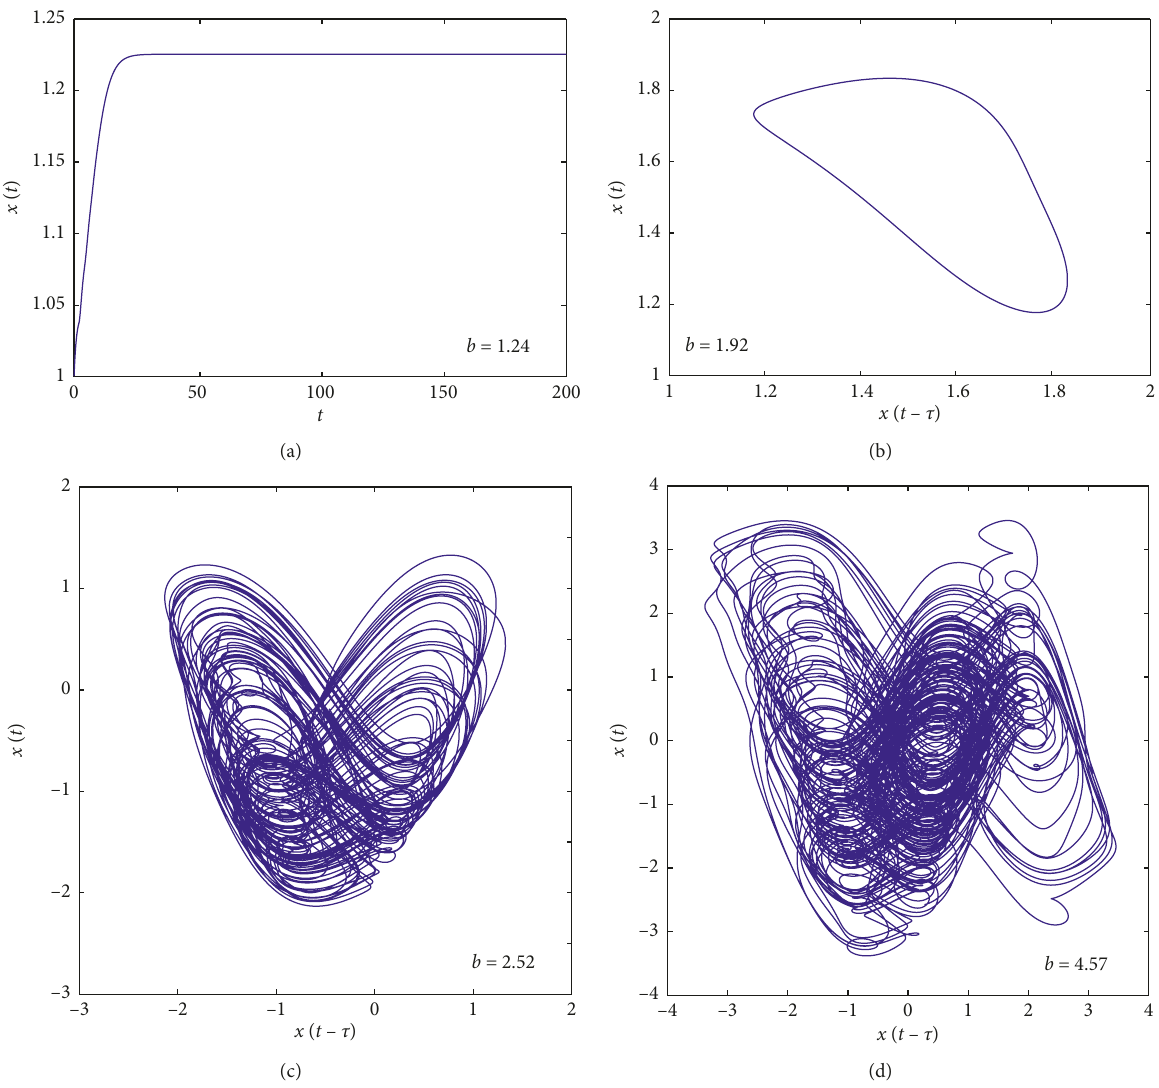
Figure 5: The initial condition is ϕ ( t ) � 1 for t ∈ [− τ , 0 ] throughout the investigation. Parameter a � 1, and time delay τ � 2. (a) Time series for b � 1 . 24, the fixed point is stable, (b) period limit cycles for b � 1 . 92, (c) chaotic attractors for b � 2 . 52, and (d) hyperchaotic attractors for b � 4 .